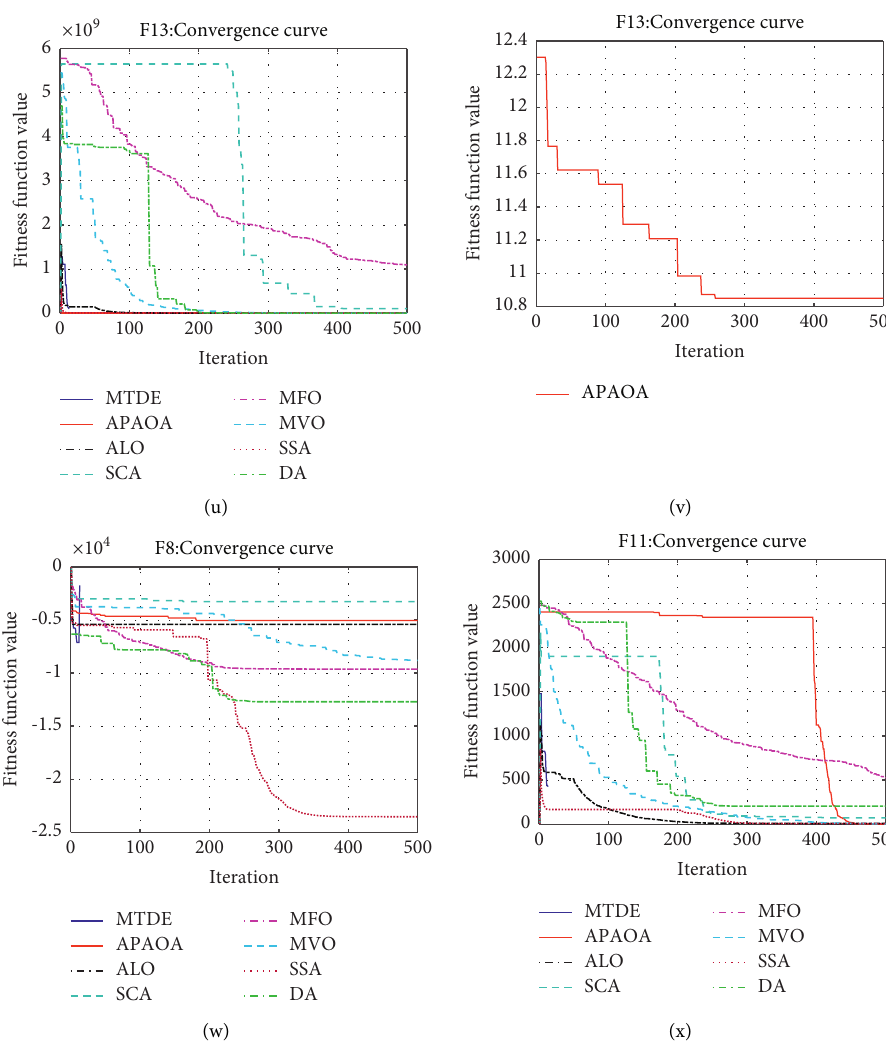
Figure 6: Comparison results of convergence performance of popular optimization